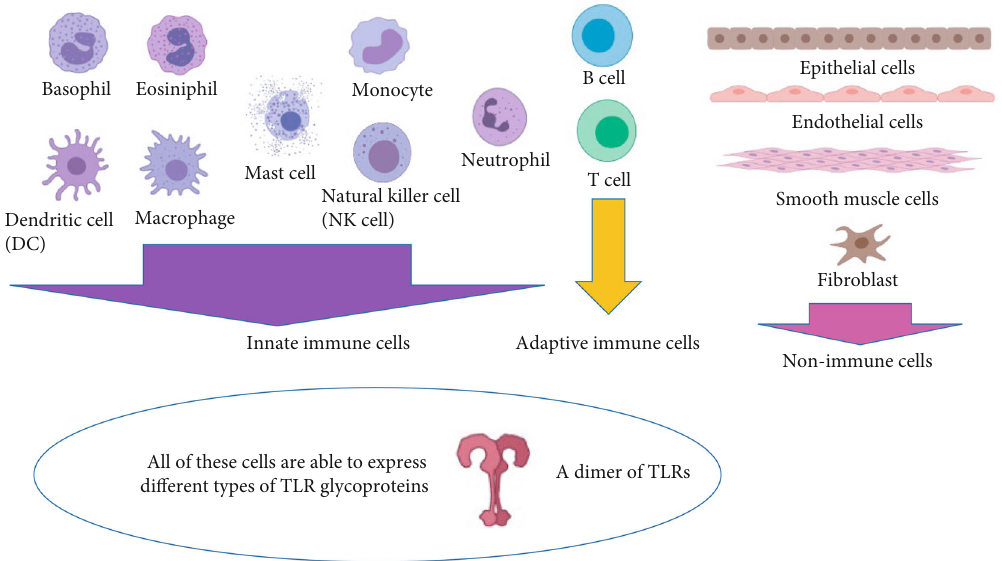
Figure 1: Di ff erent types of immune and nonimmune cells are able to express di ff erent types of TLR glycoproteins (this fi gure is prepared via the software tool serving by